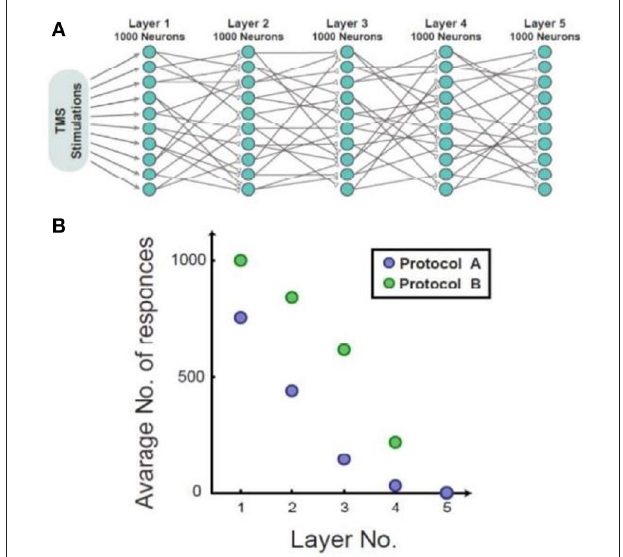
FIGURE 4 | Simulation of a feed-forward network consisting of five layers. (A) A diagram of the simulated feed-forward network. (B) The average number of responses as a function of the layer number. In the presented case, protocol B demonstrated fewer response failures in comparison to protocol A up to the 5th